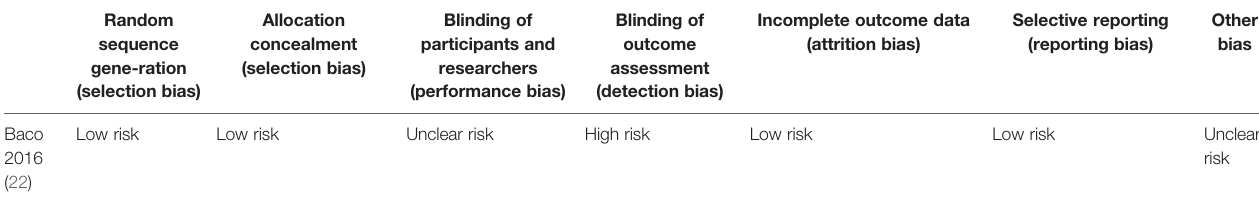
TABLE 3 | Quality assessment according to Cochrane Collaboration Risk of Bias Tool.